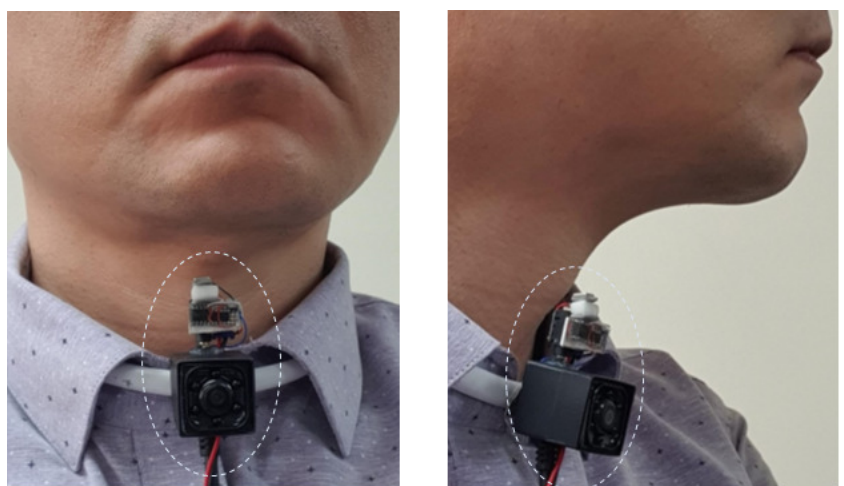
Figure 3. A photograph of a subject equipped with the developed sensor device.